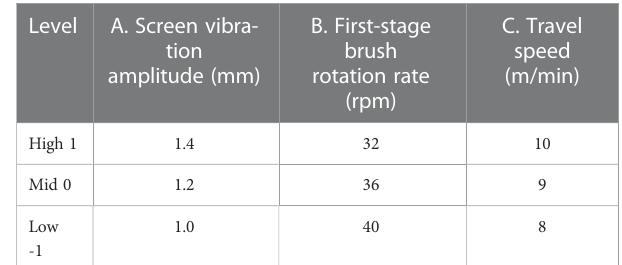
TABLE 4 Response surface experiment factor